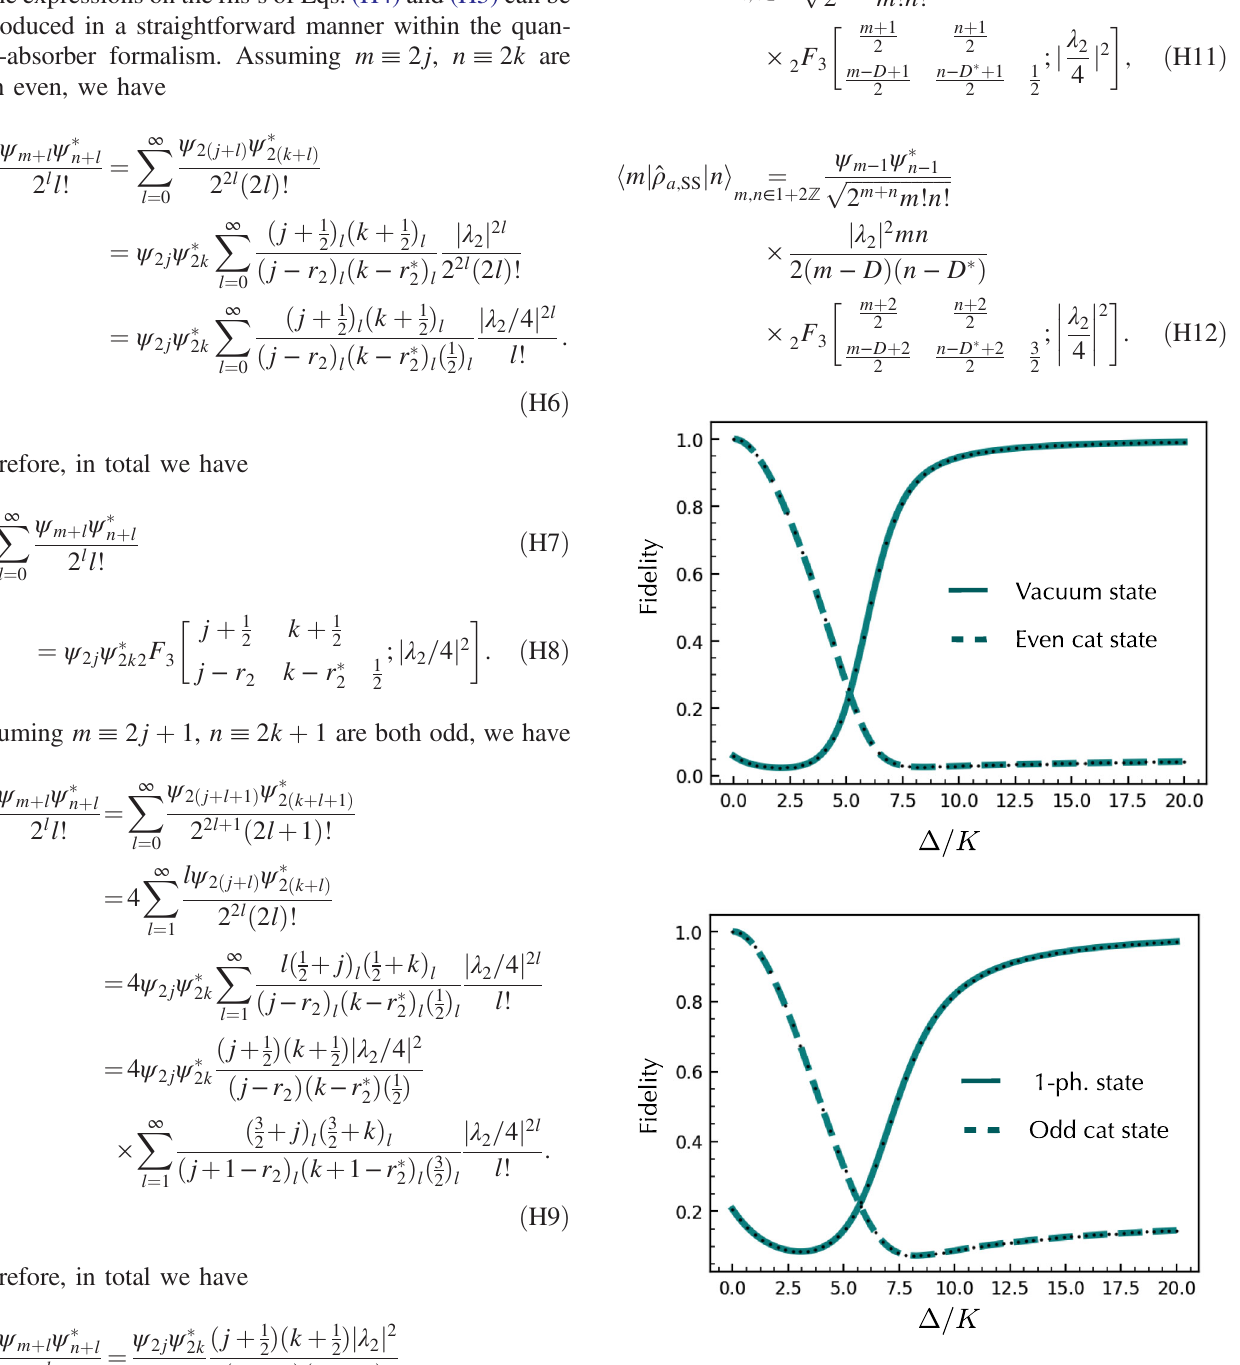
FIG. 10. Limiting behavior of bistable states. Top: We plot the fidelity of ˆ ρ [cf. Eq. (H4)] with an even cat state with amplitude ffiffiffiffiffiffiffiffiffi p e α ¼ i λ 2 (solid line) and the vacuum state (dashed line). 2 = Corresponding results from exact diagonalization are also given (black dots) Bottom: We plot the fidelity of ˆ ρ an amplitude- α odd cat state (solid line) and a one-photon Fock state (dashed line). Corresponding results from exact diagonal- ization are also given (black dots). Parameter choices: In both plots, Λ 2 ¼ 5 K , κ 2 ¼ K , and Λ 1 , κ 1 ≡ 0